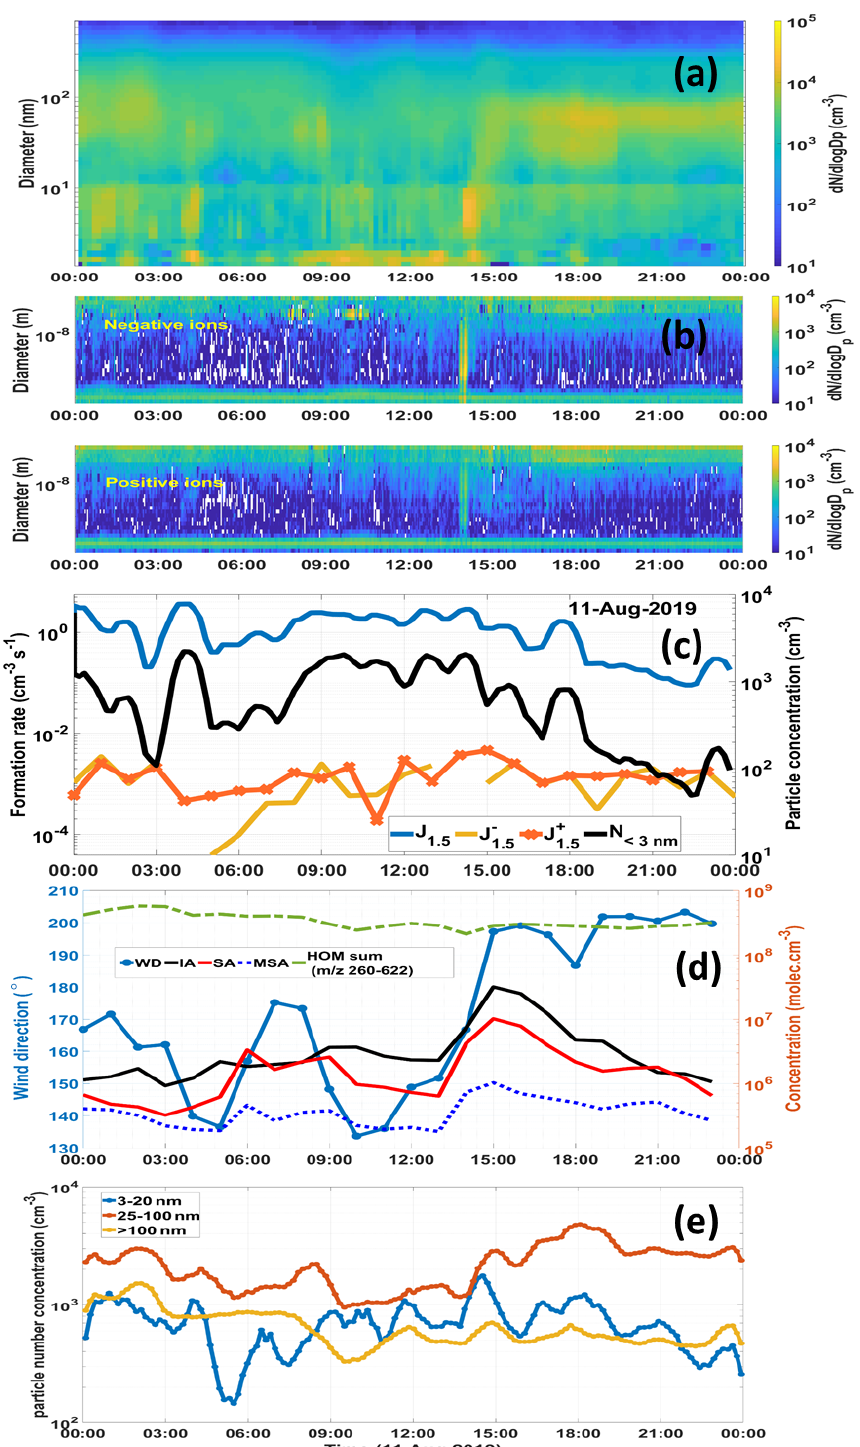
Figure 8. Burst event on 11 August 2019. (a) Number size distribution of particles (data from the PSM, the NAIS and the DMPS; size range: 1–100nm). (b) Charged-particle number size distribution (negative: upper, positive: lower) obtained from the NAIS. (c) Diurnal variation in formation rates ( J 1 . 5 ) of 1.5nm particles and ions ( J − and J + ) and total number concentrations of particles ( < 3nm, PSM). 1 . 5 1 . 5 (d) Diurnal variation in HOMs, SA, IA and MSA with wind direction (WD). (e) The diurnal variation in particle concentration in nucleation (3–20nm), Aitken (25–100nm) and accumulation mode ( > 100nm) particles (DMPS